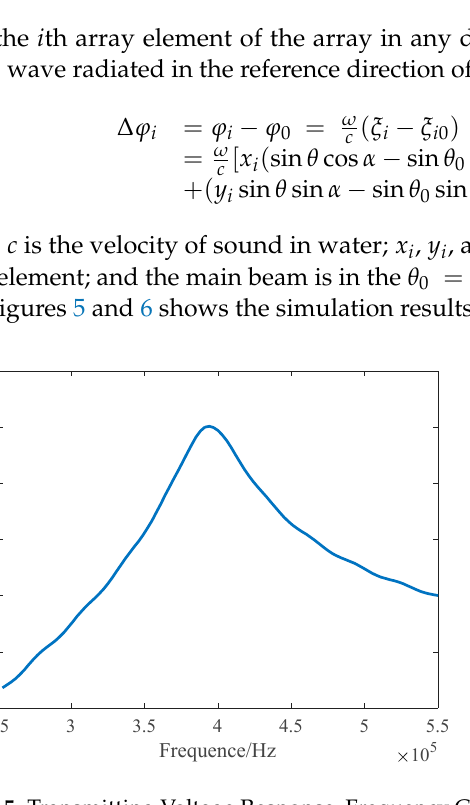
Figure 5. Transmitting Voltage Response–Frequency Curve.